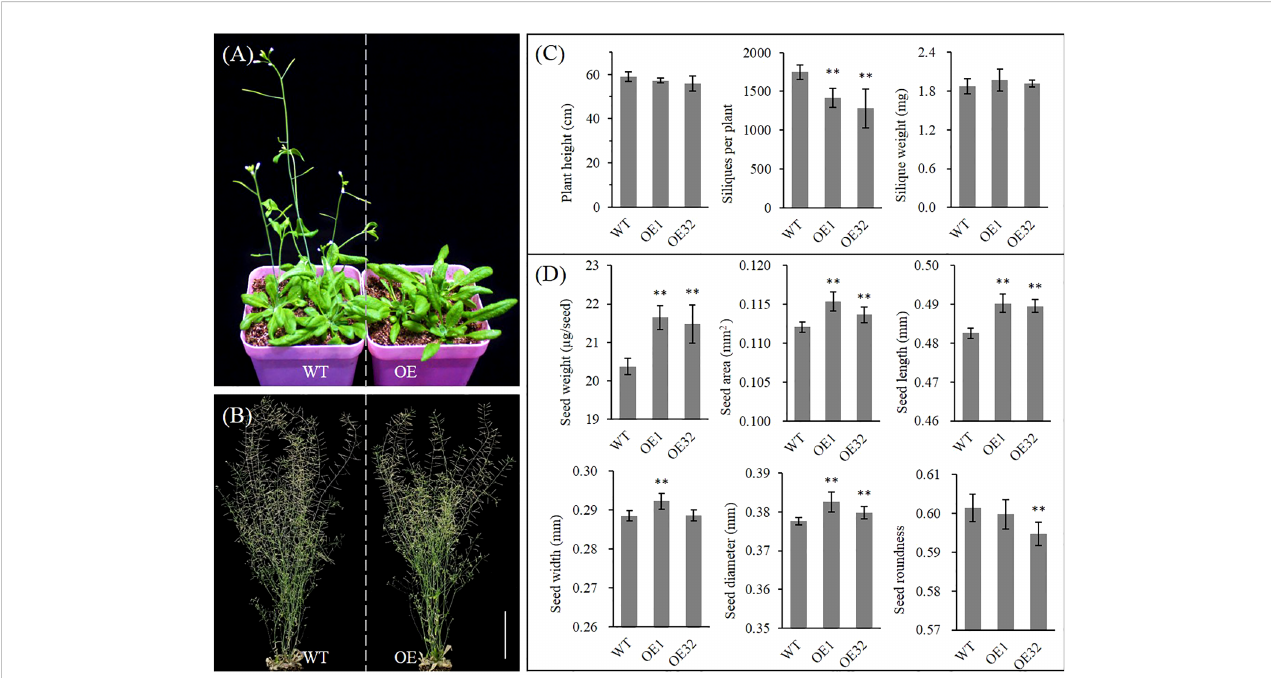
FIGURE 8 Phenotype analysis of homozygous AhGPAT9 overexpression lines in Arabidopsis . (A) Wild type (WT) and AhGPAT9 overexpression lines (OE) at 5-week- old under normal conditions. (B) Wild type (WT) and AhGPAT9 overexpression lines (OE) at maturity under normal conditions. (C) Agronomic trait analysis of WT and OE lines at maturity, including plant height, siliques per plant and mean silique weight (n = 6, bars = 10 cm). (D) Dry seed weight and seed- shape trait analyses of WT and OE lines, including mean seed area, seed length, seed width, seed diameter and seed roundness. About 3000 seeds harvested from 12 individual plants were tested in each sample (n = 12). Asterisks indicate signi fi cant differences from the WT: ** P < 0.01 (Student ’ s t - test). Data are shown as means ± standard